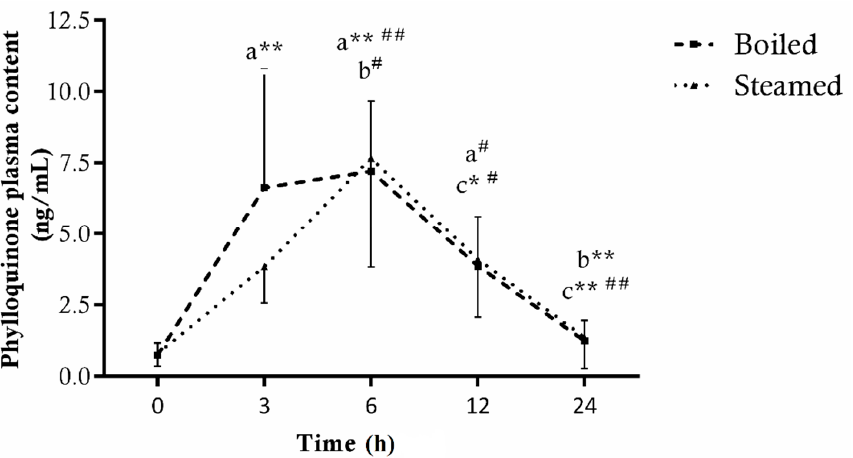
Figure 5. Total phylloquinone levels in plasma of 7 subjects before (0) and after 3, 6, 12 and 24 h consumption of broccoli cooked with boiling or steaming treatment. Data are expressed as ng/mL of plasma ± SD of three technical replicates. * p < 0.05 and ** p < 0.01 vs. 0 h (a), 3 h (b) and 6 h (c) in subjects supplemented with boiled broccoli; # p < 0.05 and ## p < 0.01 vs. 0 h (a), 3 h (b) and 6 h (c) in subjects supplemented with steamed broccoli.